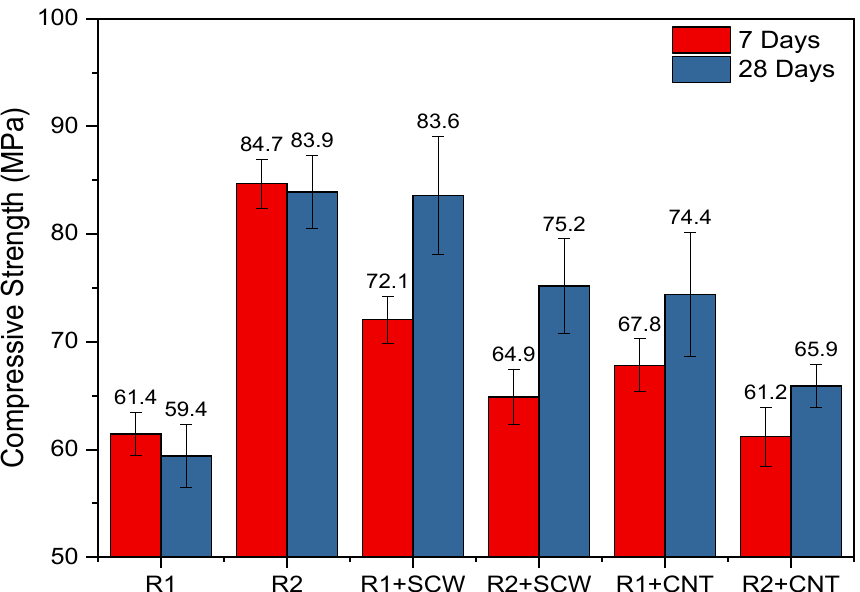
Figure 11. Compressive strength of pastes evaluated on 7 and 28 days. The R1 and R2 systems containing SCW and CNT registered different performances.